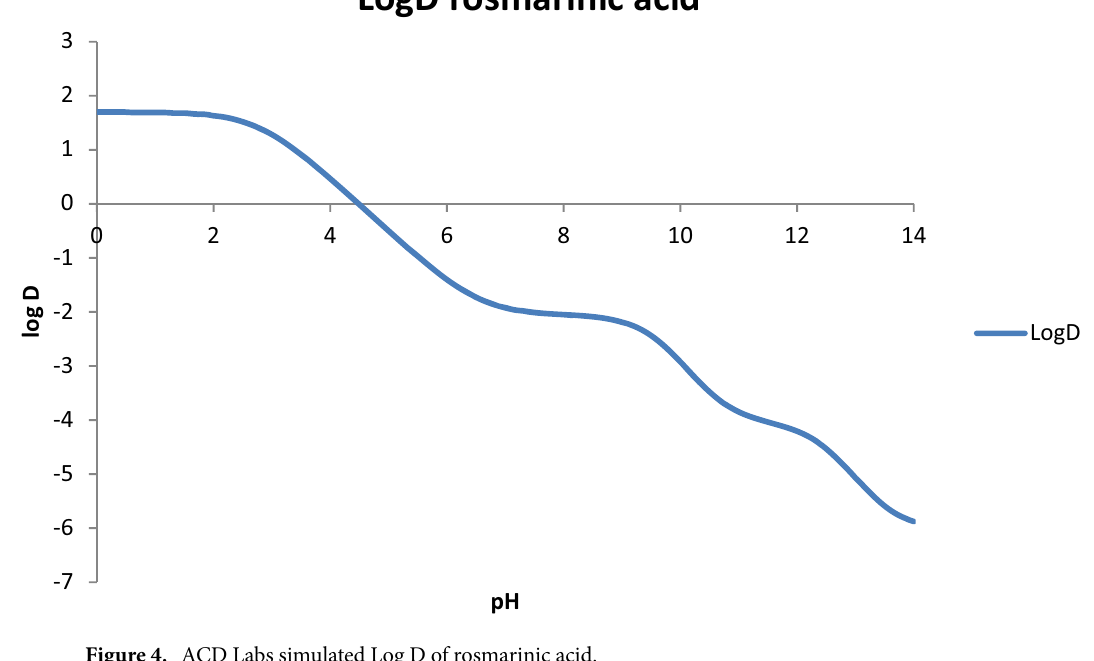
Figure 4. ACD Labs simulated Log D of rosmarinic